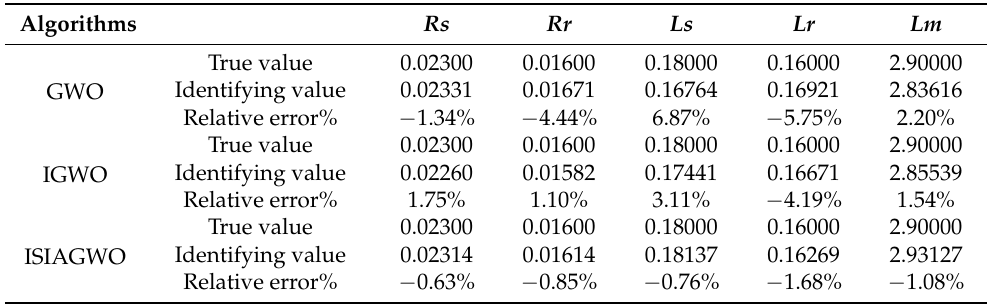
Table 6. Comparison of the results of three algorithms for the identification of generator